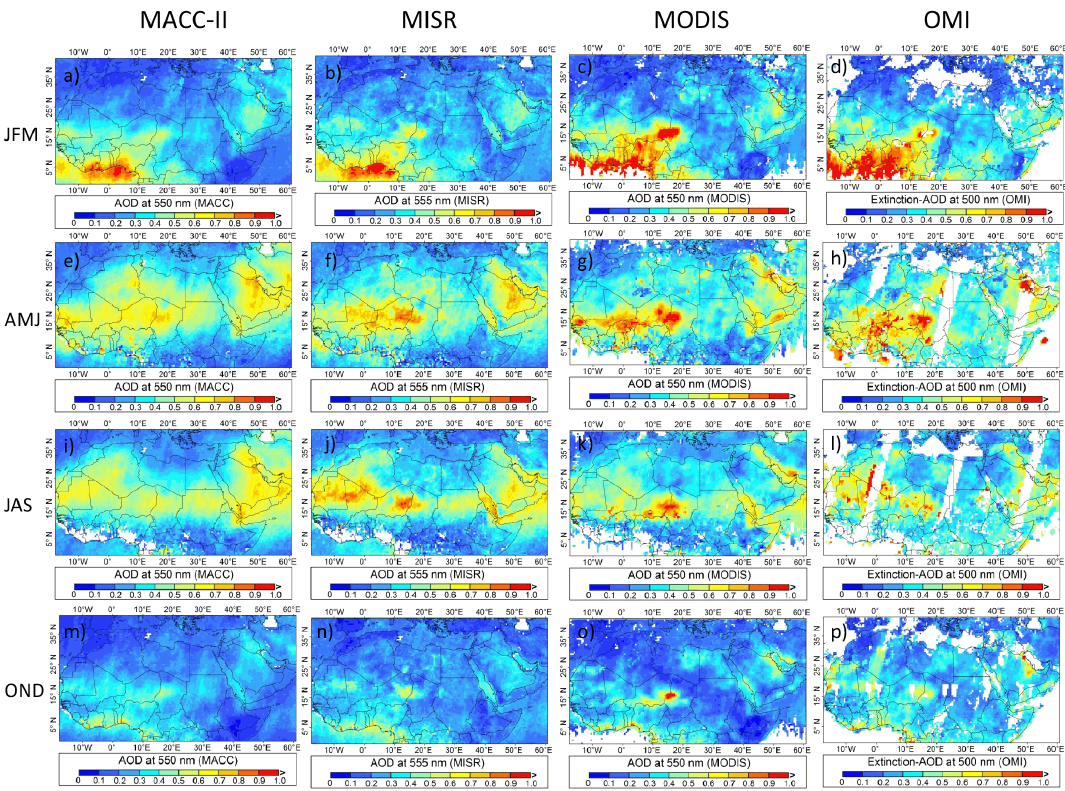
Figure 3. Seasonal AOD averages from MACC-II, MISR, MODIS and OMI for the period 2007–2008. Winter (JFM), spring (AMJ), summer (JAS) and autumn (OND). AOD averages have been computed using only those common pixels of simultaneous days, for each MISR pass, for MACC-II, MODIS and